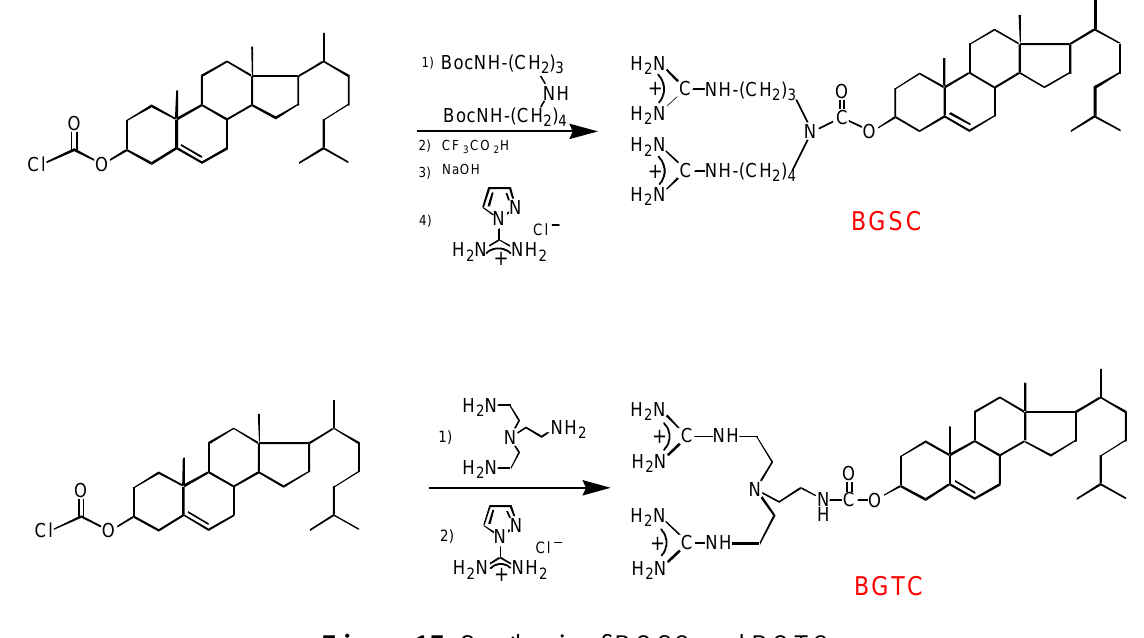
Figure 17. Synthesis of BGSC and